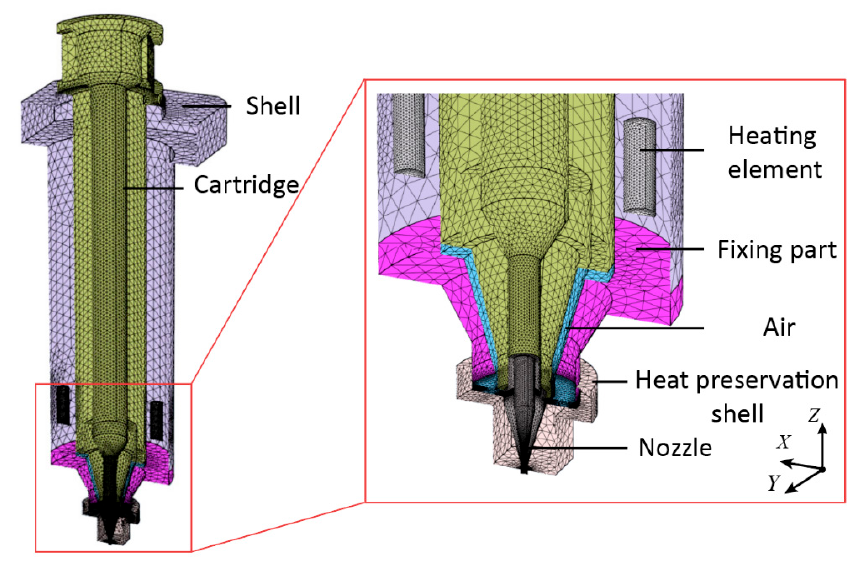
Figure 3. The computational mesh of the print head.